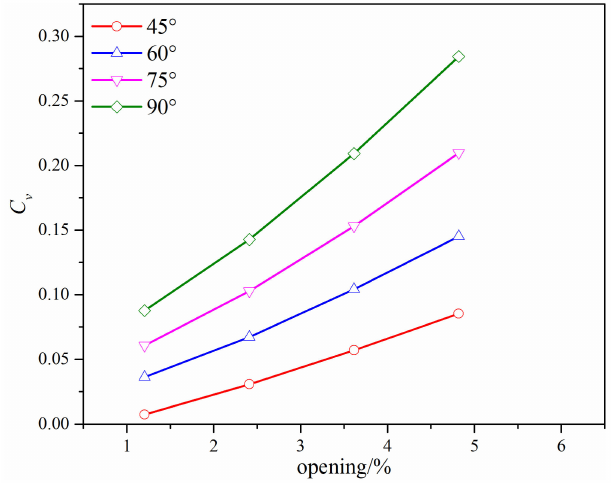
Figure 10. The flow coefficient of the improved V-ball valve with different β degrees when l = 50 mm. If the head of the cutting tool has a rectangular lateral surface, the formed gap on the V-ball can have a larger flow cross-area. The structure of the improved #2 V-ball is shown in Figure